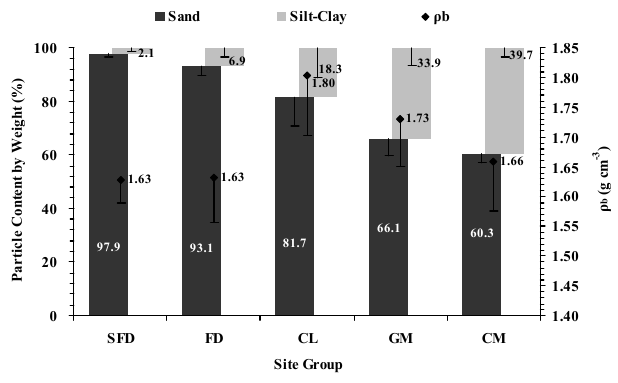
Fig. 6. The soil organic matter (SOM), electrical conductivity (EC), and pH of the study area. Values are means ± standard deviations. SFD stands for semi-fixed dune sites, FD for fixed dune sites, CL for cultivated land sites, GM for general meadow sites, and CM for control meadow sites where there was no detectable erosion and sand accumulation.